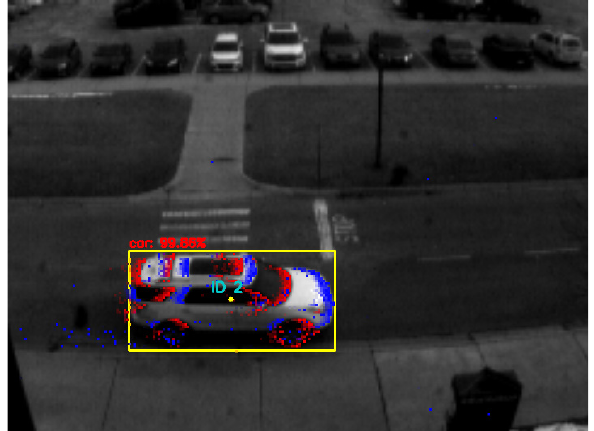
Figure 8. The figure demonstrates an image with temporally weighted events (visualized by the transparency effect) overlayed on top. Faded blue and red dots resemble older positive and negative events, respectively. This scene represents the same time instance as the one shown in Figure 4 at a tracking rate of 48 Hz, though with an extended 50 ms of event data history compared to 21 ms. To weight the events temporally , we use the following equation for each event: